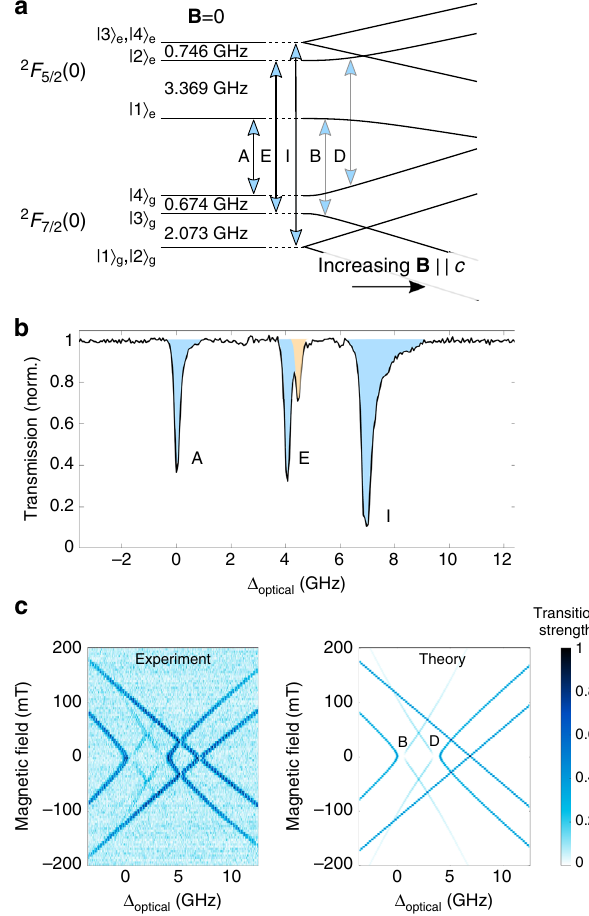
Fig. 2 Magnetic fi eld dependence of 171 Yb 3 + :YVO 4 optical transition frequencies and strengths. a Energy level structure for 171 Yb 3 + :YVO 4 with the permitted optical transitions for light polarized along the c- axis. Transitions A (304,501.0 GHz ≈ 984.54 nm), E, and I are the allowed, spin- preserving transitions at zero magnetic fi eld, whereas transitions B and D only become allowed for | B | ≠ 0. b Transmission spectrum of the Yb 3 + : YVO 4 nanophotonic waveguide (total length ≈ 60 µ m) at a temperature of ~1 K at | B | = 0. The light is polarized along the c -axis and the spectrum is normalized to the transmission far off-resonance. The 171 Yb 3 + transitions (A, E, and I) are shaded blue and the impurity even Yb 3 + transition is shaded orange. c Comparison of the magnetic fi eld-dependent relative transition strengths of ions in the waveguide device compared to the predicted transition strengths from spin Hamiltonian theory 22 . Each horizontal slice of the two-dimensional Experiment data is a normalized transmission spectrum like that in b . The level of absorption is proportional to the transition Supplementary Note 2 for an overview of 171 Yb 3 + :YVO 4 energy levels).